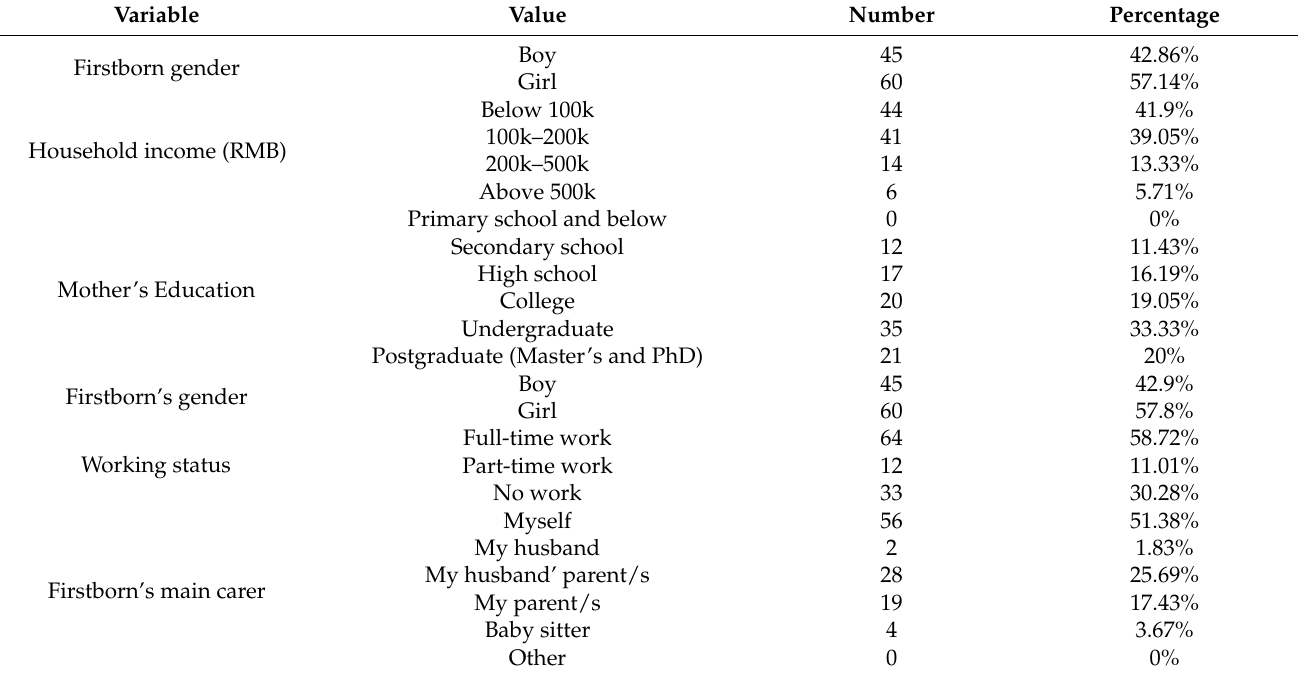
Table 1. Demographic variables ( N =